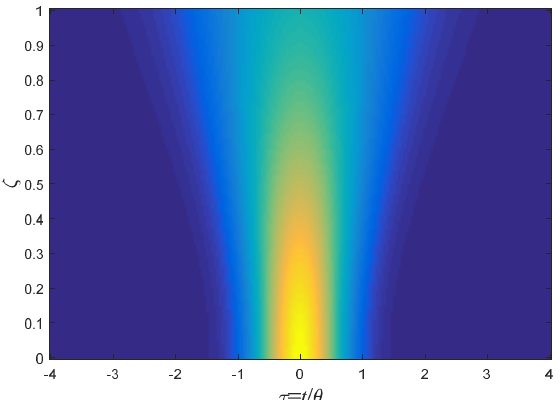
 z ), while the solid curve 2  z . Time is measured in 2